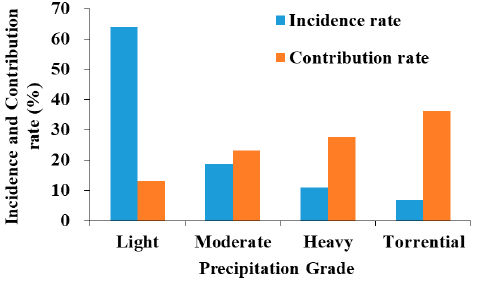
Figure 5. Incidence rate and contribution rate of different precipitation grades during rainy season in the Beibu Gulf.